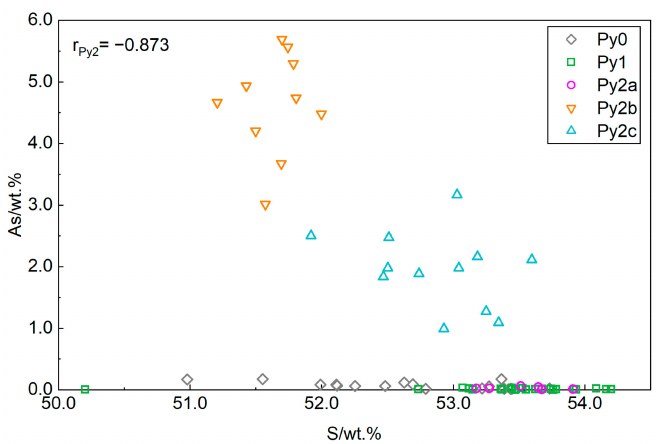
Figure 12. Binary S vs. As plot for the Dunbasitao pyrites, showing the significant negative correlation between As and S. The S contents are based on EPMA data, and the As contents are based on LA- ICP-MS